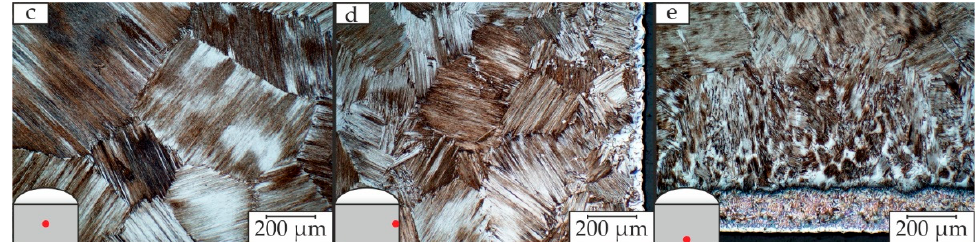
Figure 11. Microstructure in defined positions c, d and e according to Figure 1 (right) of a GE48 sample sintered at 1350 °C, with 10 min dwell time and 65 MPa pressure.